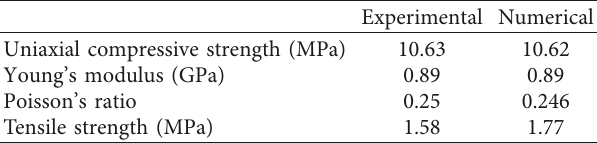
Table 3: Comparison of experimental and numerical